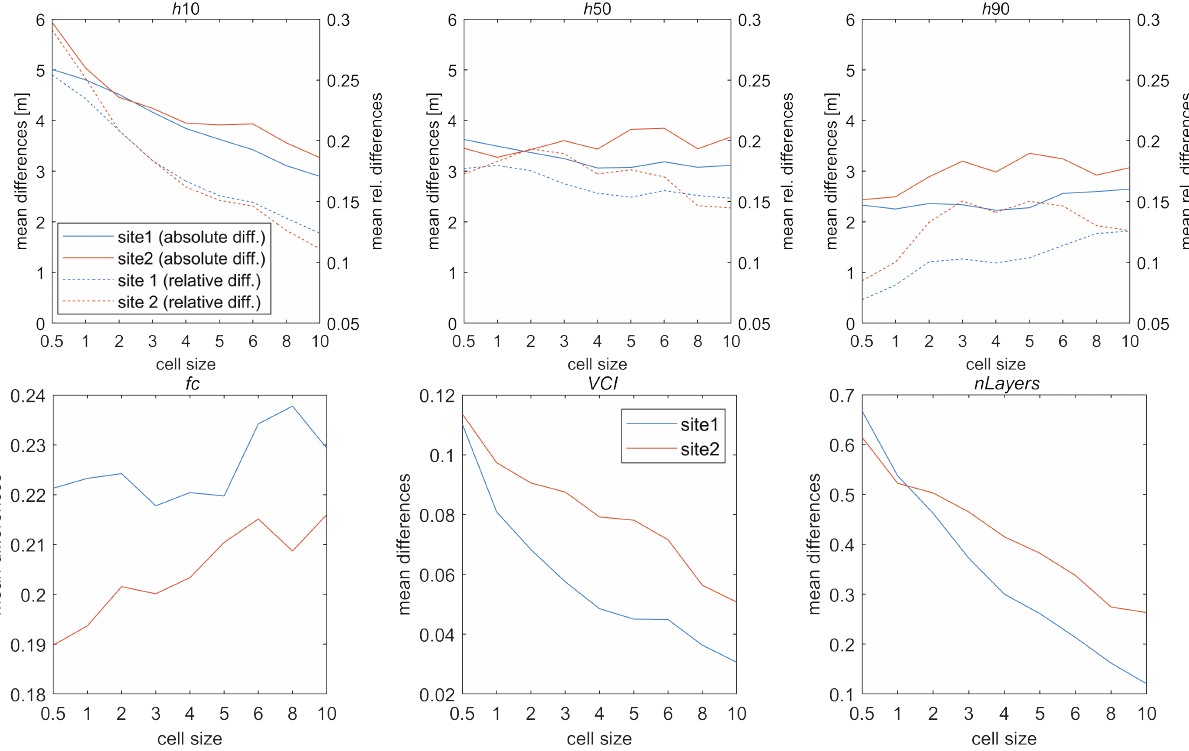
Figure 4. Top row, left to right: Mean differences (solid lines, left y-label) and mean relative differences (dashed lines, right y-label) in h 10, h 50, h 90 from ULS and ALS as function of the cell size for which the metrics were computed. Bottom row, left to right: Mean differences in fc , VCI , nLayers from ULS and ALS.